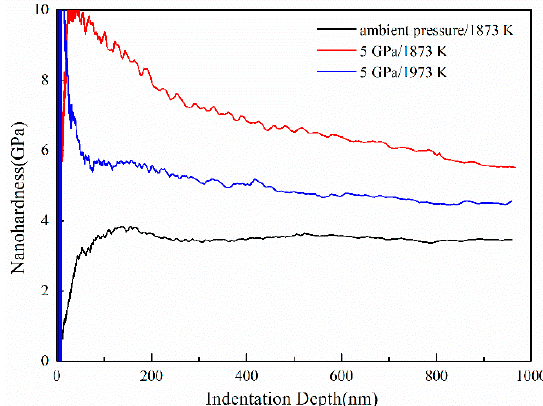
Figure 6. Hardness-depth curves obtained from solidified Ti-48Al-2Cr alloy under di ff erent pressures. Table 1. The average nanohardness of the Ti-48Al-2Cr alloy solidified under di ff erent pressures. Sample